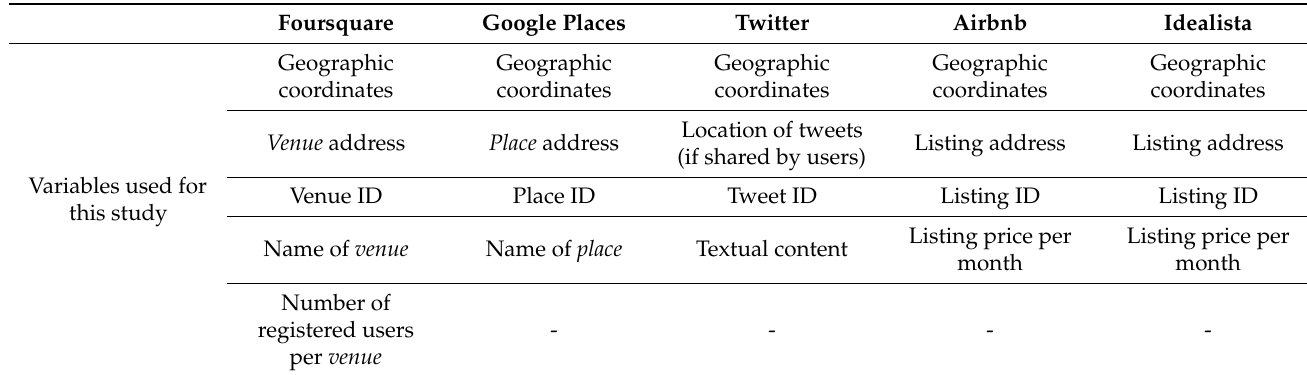
Table 1. Social network